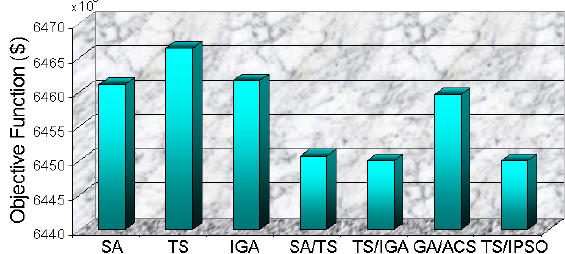
Figure 7. Comparison of the proposed algorithm with other modern algorithms in case 1.